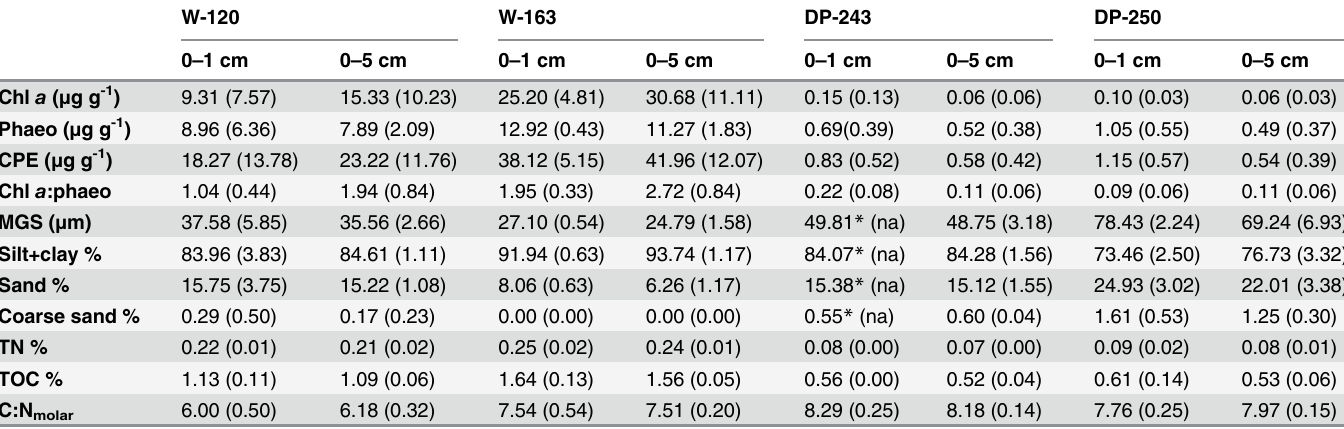
Table 3. Sedimentary environmental variables per station ( ± standard deviation), both for the upper centimetre separately and averaged over all replicates and